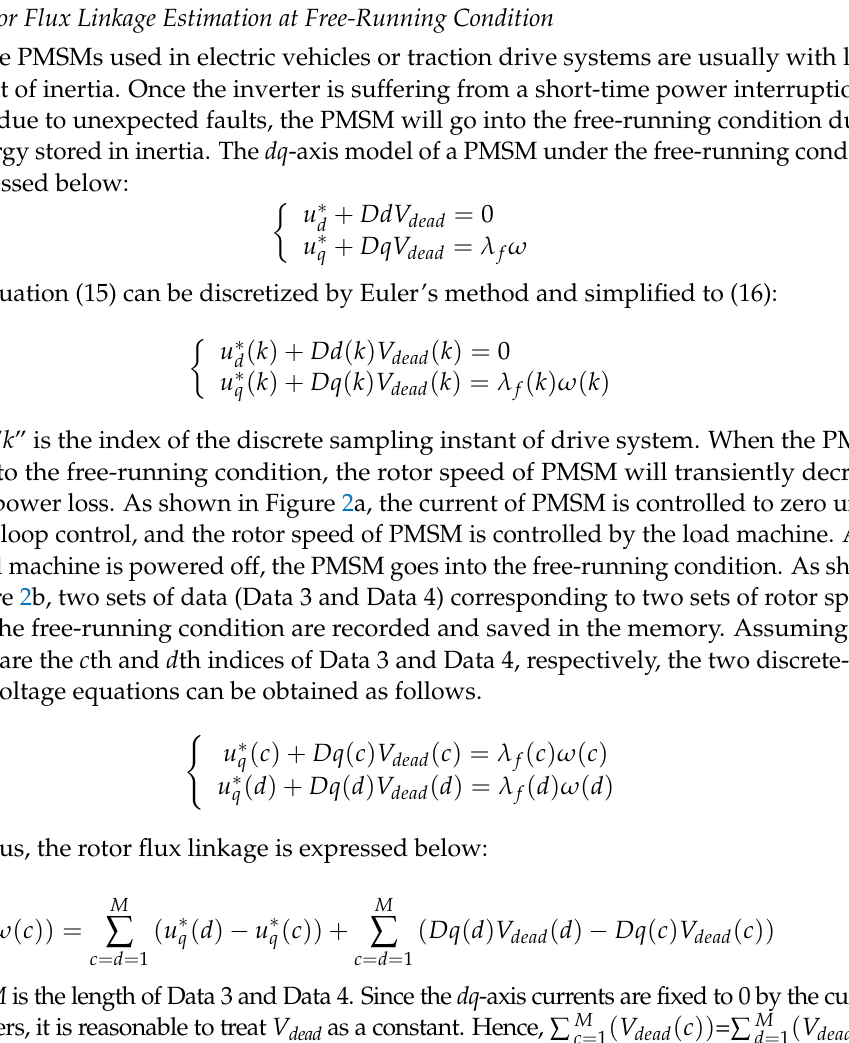
Figure 1. Zero-voltage injection-based approach under variable speed control. ( a ) Schematic dia- gram of zero-voltage injection-based approach; ( b ) processes of data measurement and parameter estimation of the proposed method.